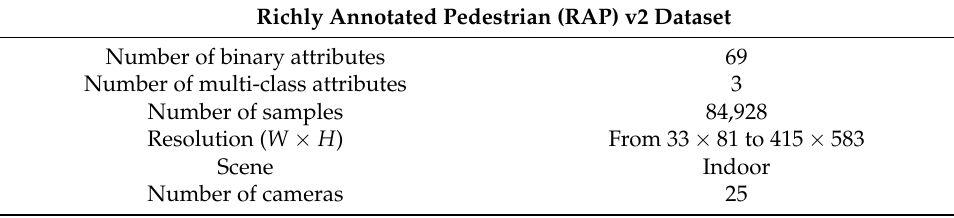
Table 1. RAP v2 dataset description. Richly Annotated Pedestrian (RAP) v2